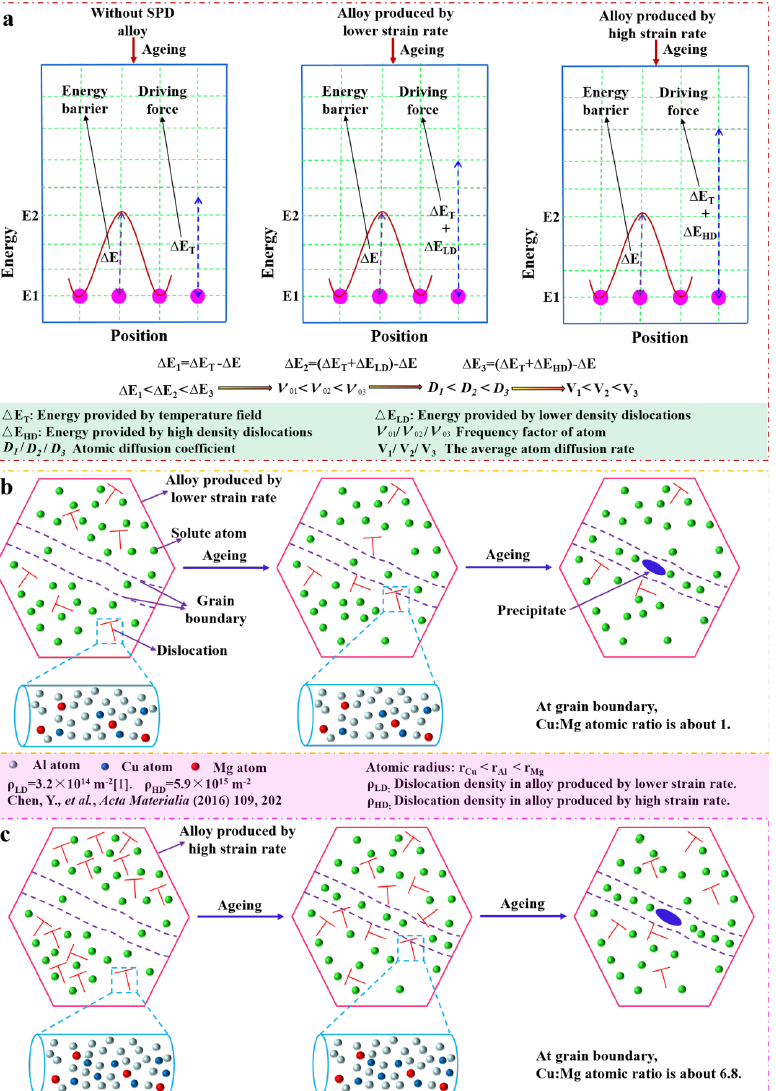
Figure 12. Atomic diffusion in alloys produced with a low or high strain rate during the aging process. Sketch of ( a ) diffusion driving force, diffusion process in alloys produced with a low [24] ( b ) and high ( c ) strain rate.